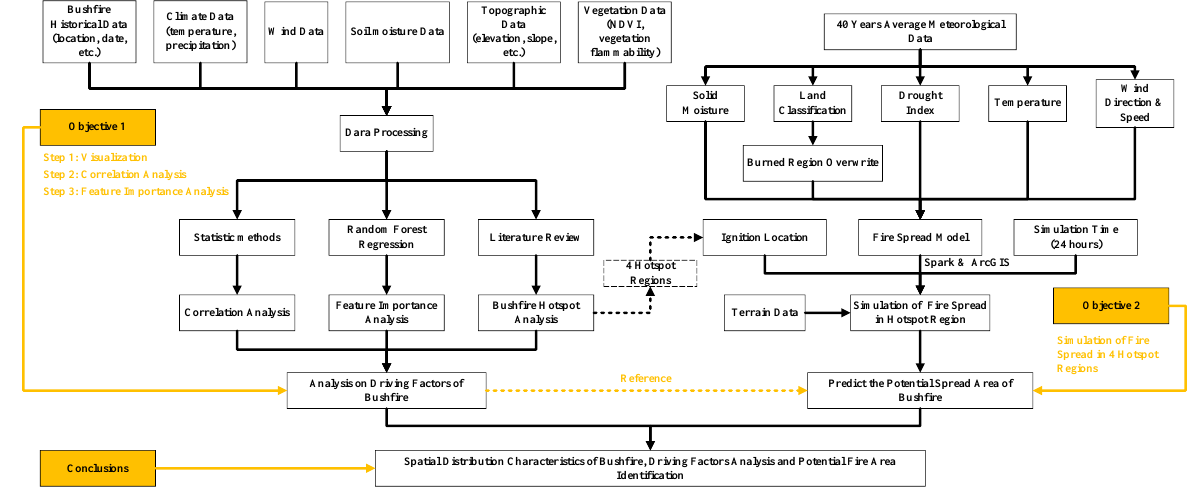
Figure 1. Research flowchart.